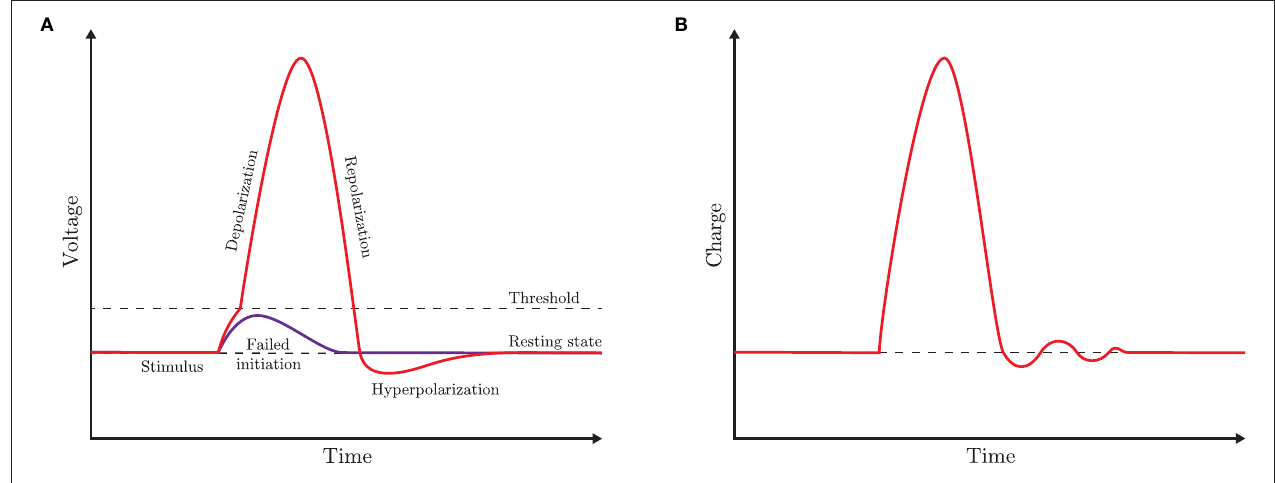
FIGURE 2 | (A) Schematic of an ideal voltage-pulse of the cellular membrane (action potential). (B) Reference shape of the memristor charge-pulse considered in this paper. For the sake of simplicity, the depolarization is assumed to occur without distinction between the sub- and the super-threshold branches, and the hyperpolarization dynamics admits small ripples during the convergence to the resting state.